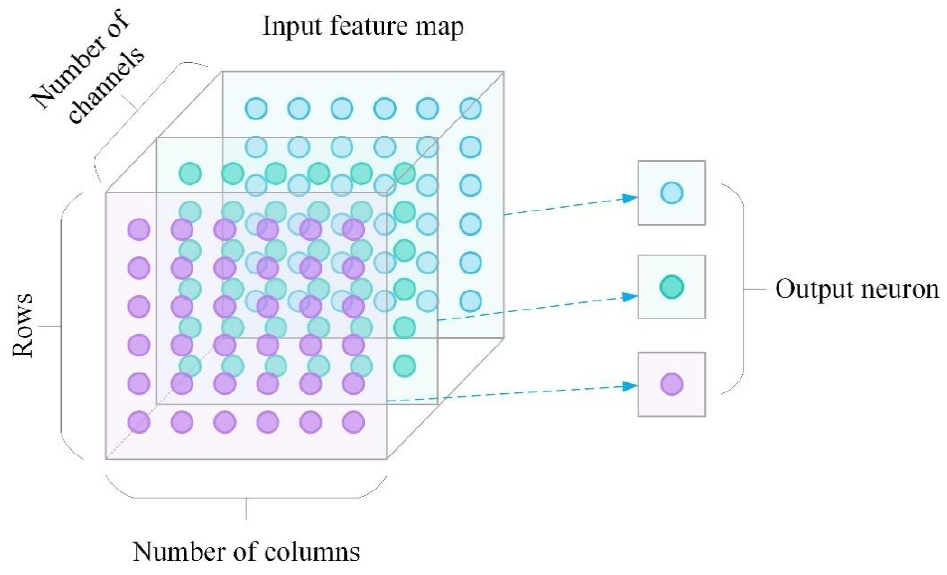
Figure 5. The schematic diagram of the global average pooling.